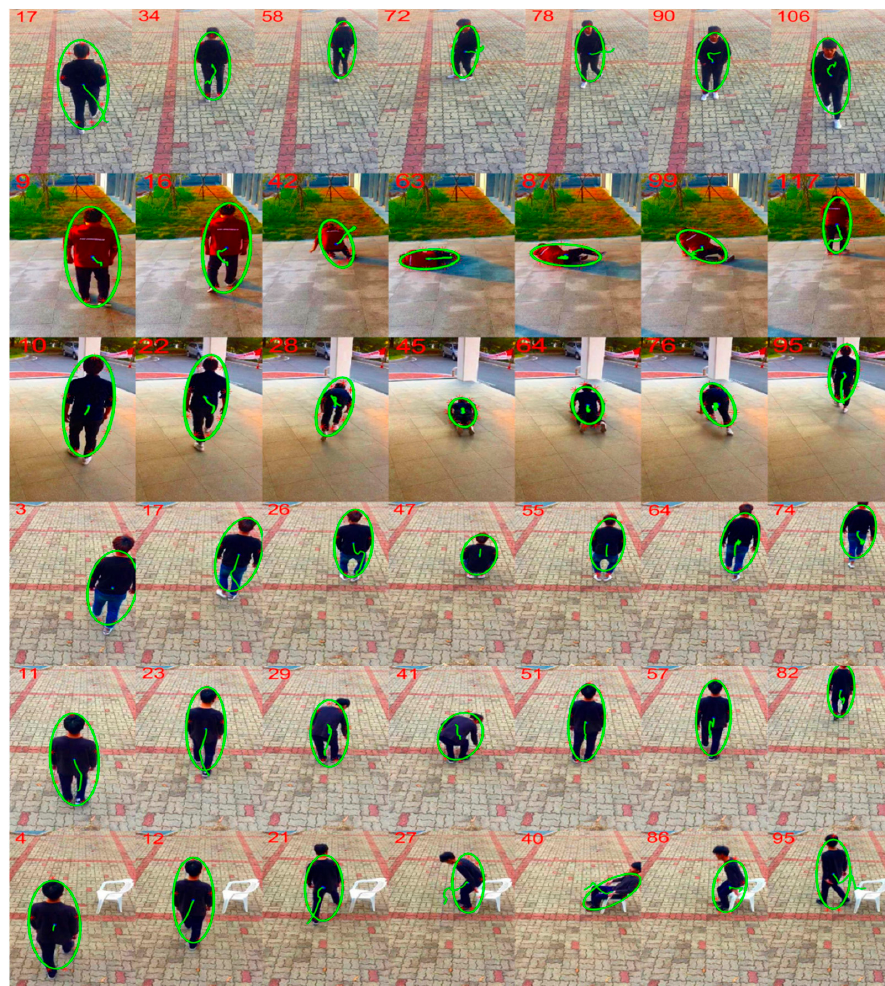
Figure 17. Resulting images of human tracking for various confounding cases: green colored ellipses demonstrate successful tracking and the red numbers are the image frame number.